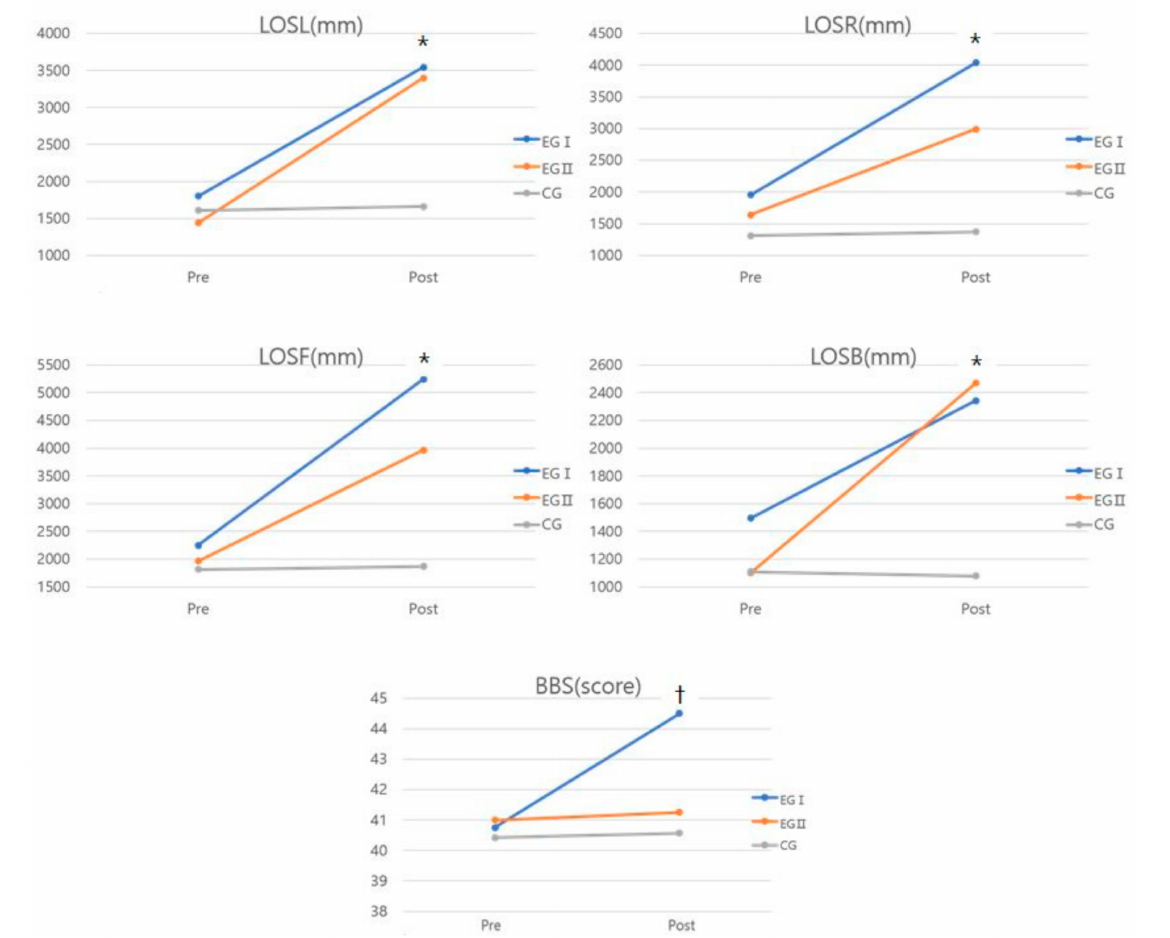
Figure 2. Comparison of balance function for each group. * Significant difference between the EGI and CG, EGII and CG. † Significant difference between the EGI and EGII, CG. Table 3. Comparison of gait function for each